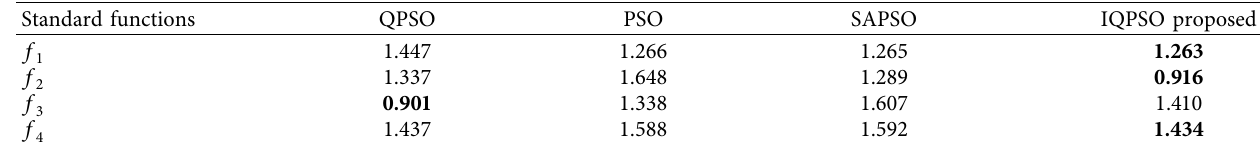
Table 4: The computing time.